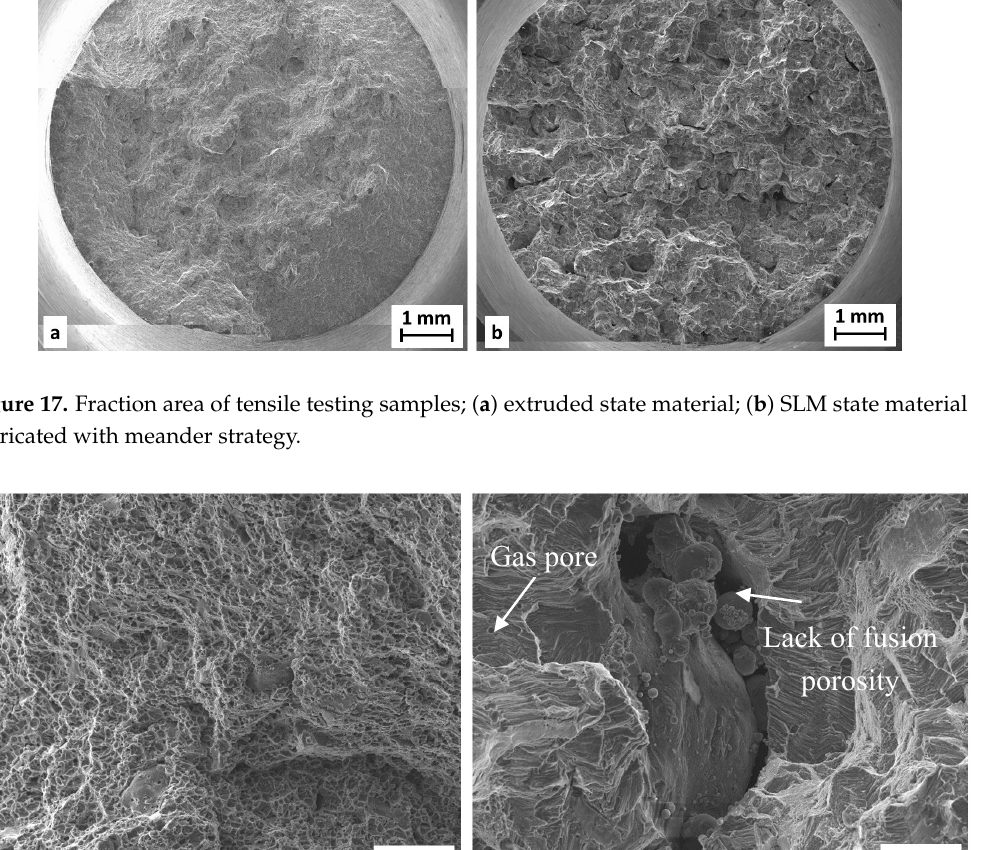
Figure 18. Detail of fraction area—( a ) extruded state; ( b ) SLM state (meander).